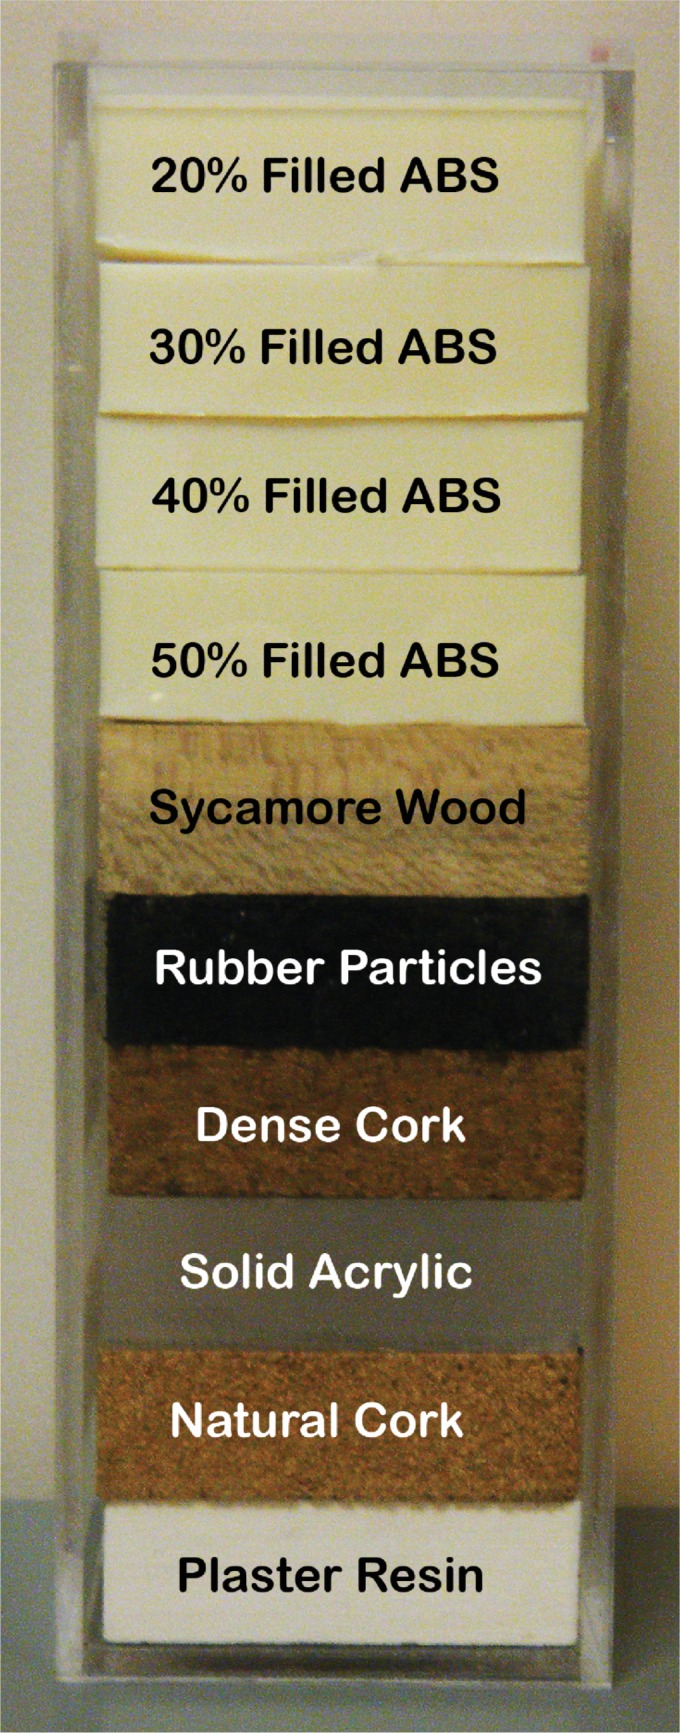
The credence cartridge radiomics phantom.